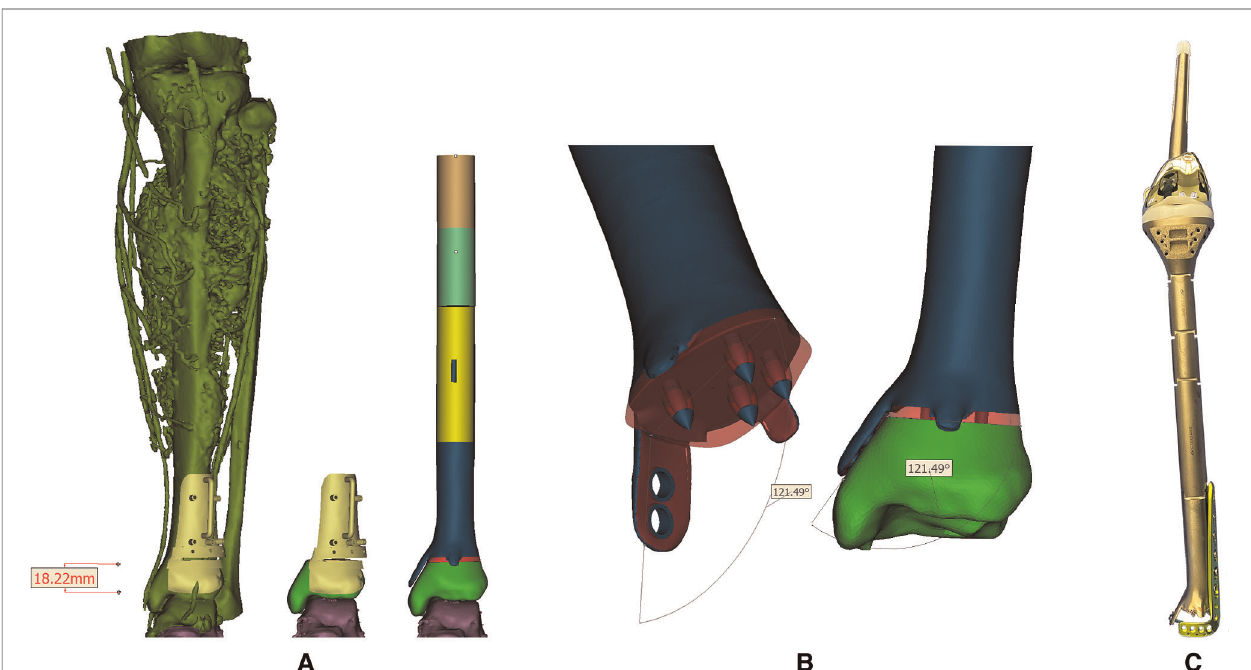
FIGURE 2 | ( A ) Reconstructed tumoral 3D model and the reconstruction plan by a custom-made prosthesis after tumor resection with the aid of PSG. Blue, red parts, and the PSG were 3D-printed while the leftover shaft was fabricated by traditional manufacturers; ( B ) Design of the 3D-printed prosthesis equipped with extracortical plates and porous structure. Red region: porous structure; blue region: solid structure; ( C ) The real picture of the reconstruction